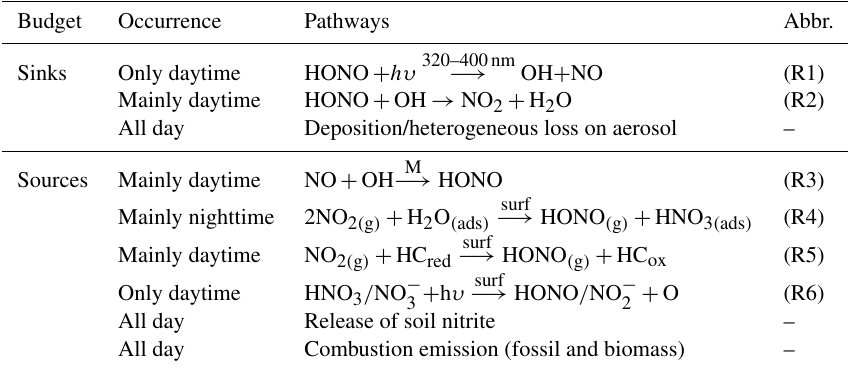
Table 1. Sources and sinks for HONO in the